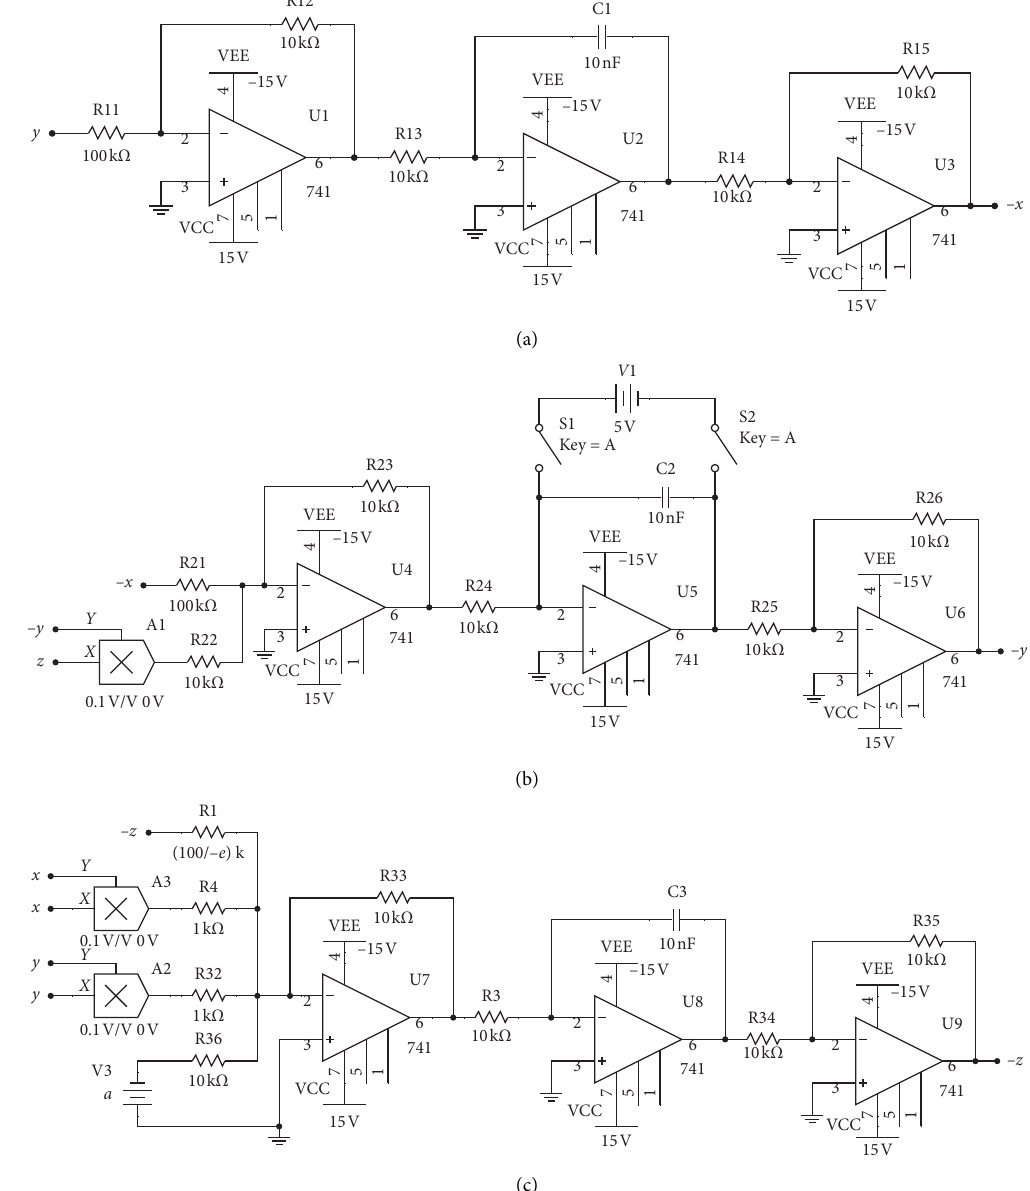
Figure 7: Circuit principle diagram. (a) Circuit principle diagram of state x . (b) Circuit principle diagram of state y . (c) Circuit principle diagram of state z